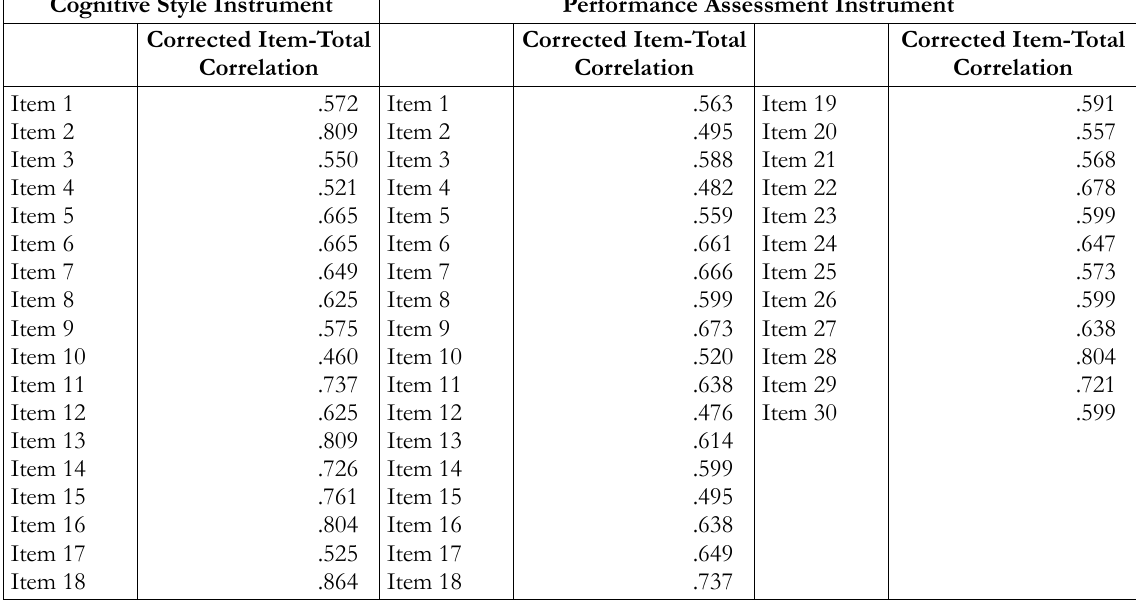
Table 3. Validity Test of Cognitive Style and Performance Assessment Instrument